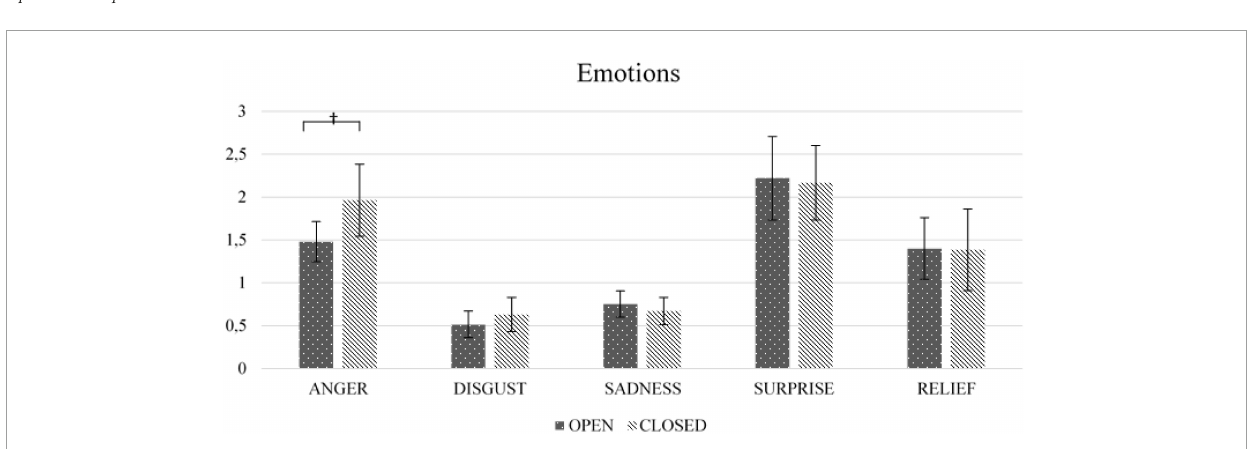
FIGURE3 Differences in emotions preceding open and closed questions. † = 0.088. N = 60.